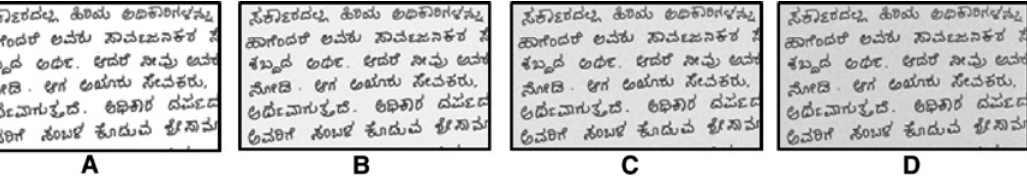
Figure 6: Illustration of (A) Original Handwritten Kannada Image at Second-Level Decomposition, and Addition of Gaussian Noise at (B) 10%, (C) 20%, and (D) 30%.